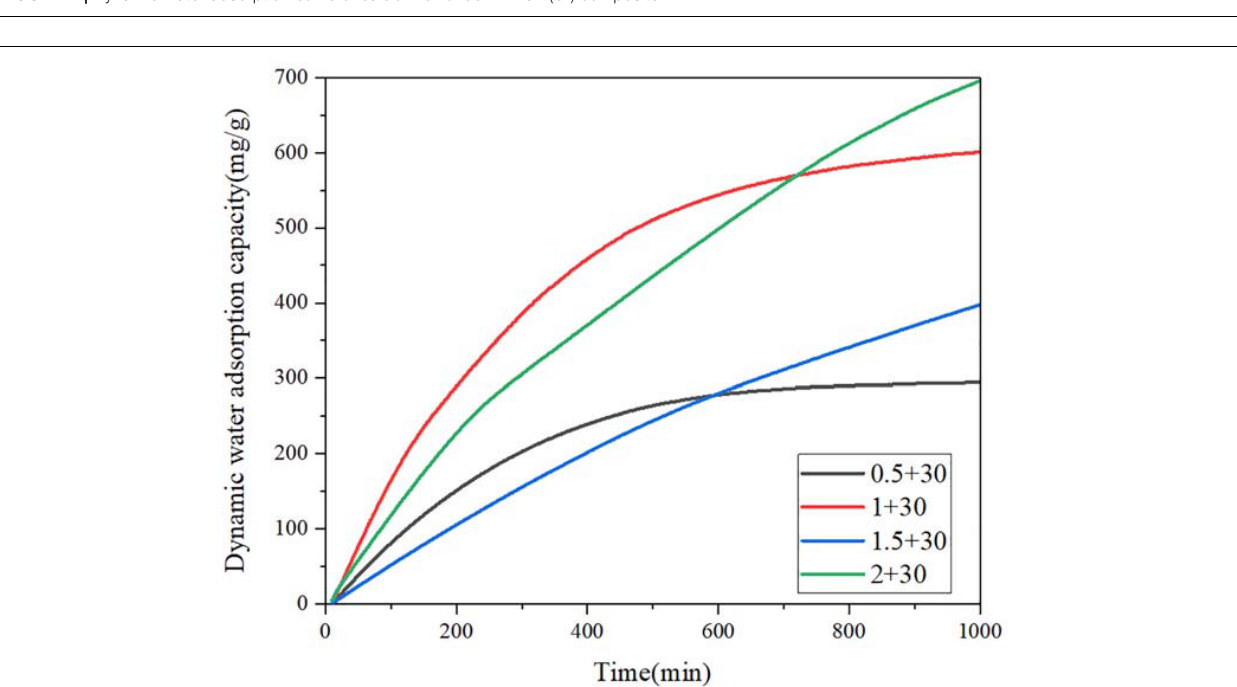
FIGURE 8 | Dynamic water adsorption curve of carbon nanotubes calcium chloride mil 101 (Cr) composite.